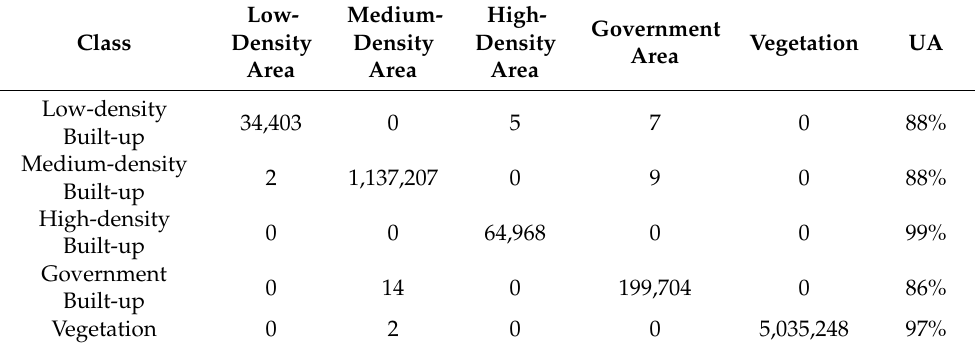
Table 5. Rapid Eye 2010 image classification confusion matrix class.